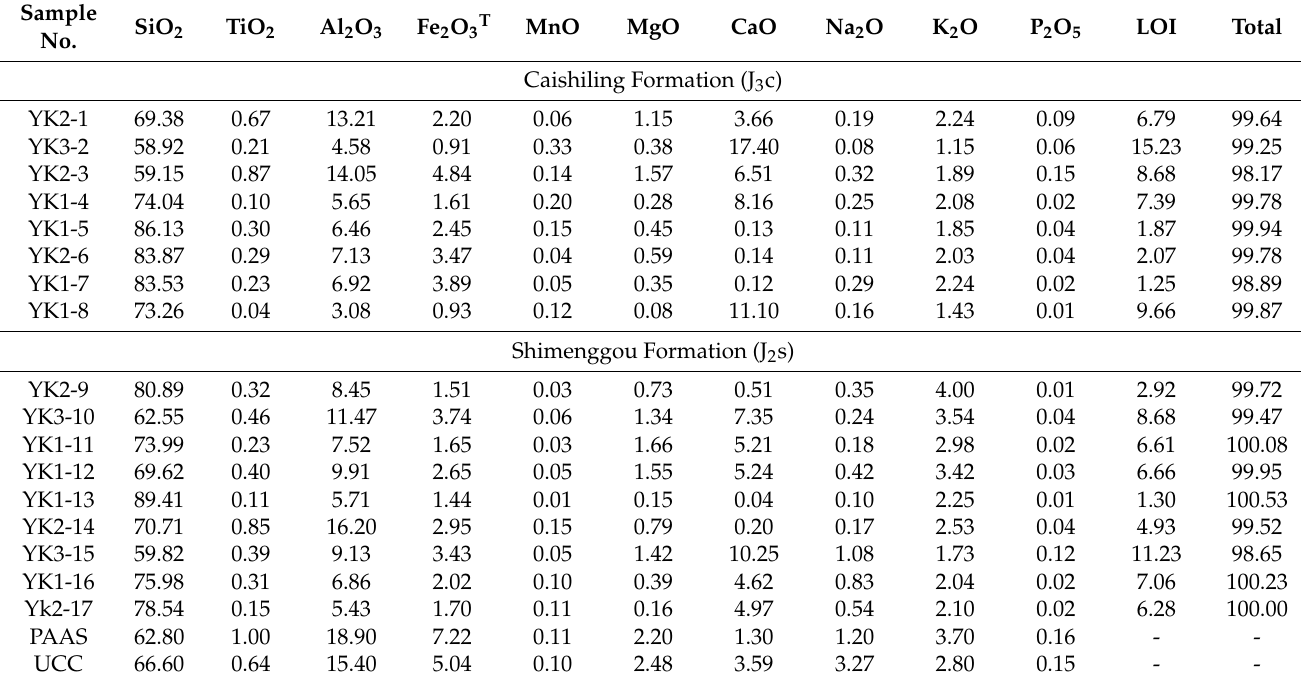
Table 1. Major element analysis results of Jurassic sandstones in the Yuqia Area (w B /%).